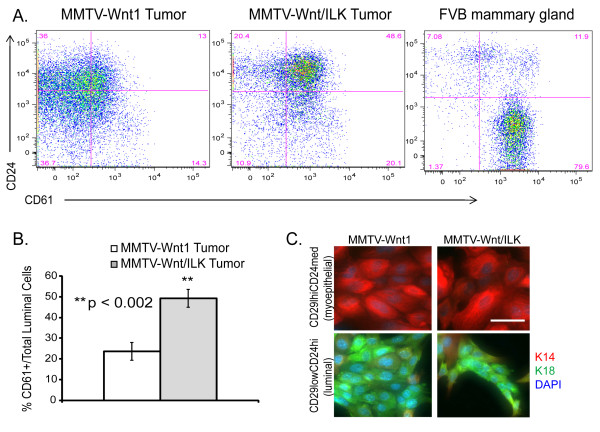
Flow-cytometry analysis and relative proportions of cell types. (a) Flow-cytometry analysis showing the distribution of Lin-CD29lo for the expression of the surface markers CD24 and CD61. Mammary glands from 10-week-old FVB mice were included as a control for the expression of these cell-surface markers and analysis by FACS. The increase in CD24hiCD61+ luminal progenitor cells is evident in the tumor cells of the MMTV-Wnt/ILK transgenic model compared with MMTV-Wnt (n = 3 per group). (b) Bar chart depicting the relative proportion of the CD61+ luminal progenitor cells to the total luminal population (CD29loCD24hi) in the two tumor types. Error bars indicate mean ± SD. **P < 0.002 was calculated by using a paired two-sample t test. (c) The purity of the cell populations (myoepithelial and luminal) in the sorted fractions is shown by the lineage-specific markers, K18 and K14, in the cultured tumor cells of both transgenic models. Scale bars, 25 μm.